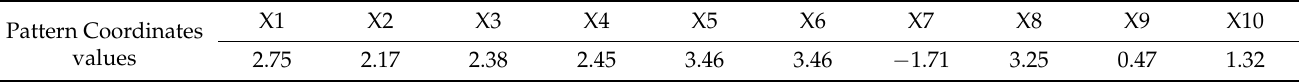
Table 4. Pattern coordinate values after standardization.